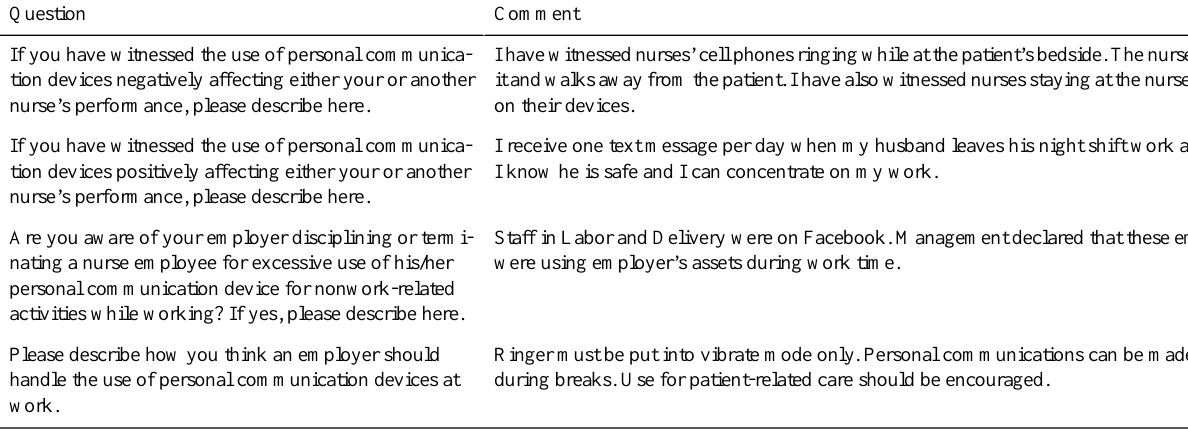
Table 7. Comments provided in response to open-ended questions in online pilot